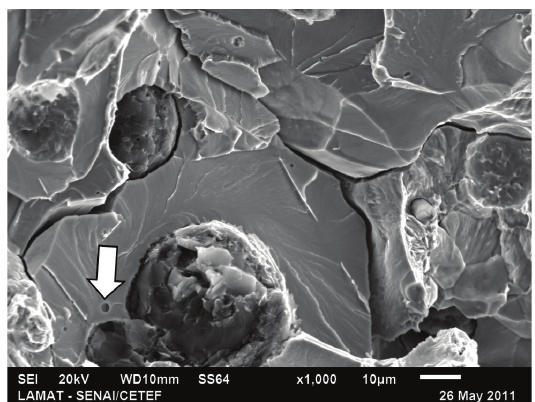
Figure 7. Magnification of the central part of Figure 6 (indicated by the